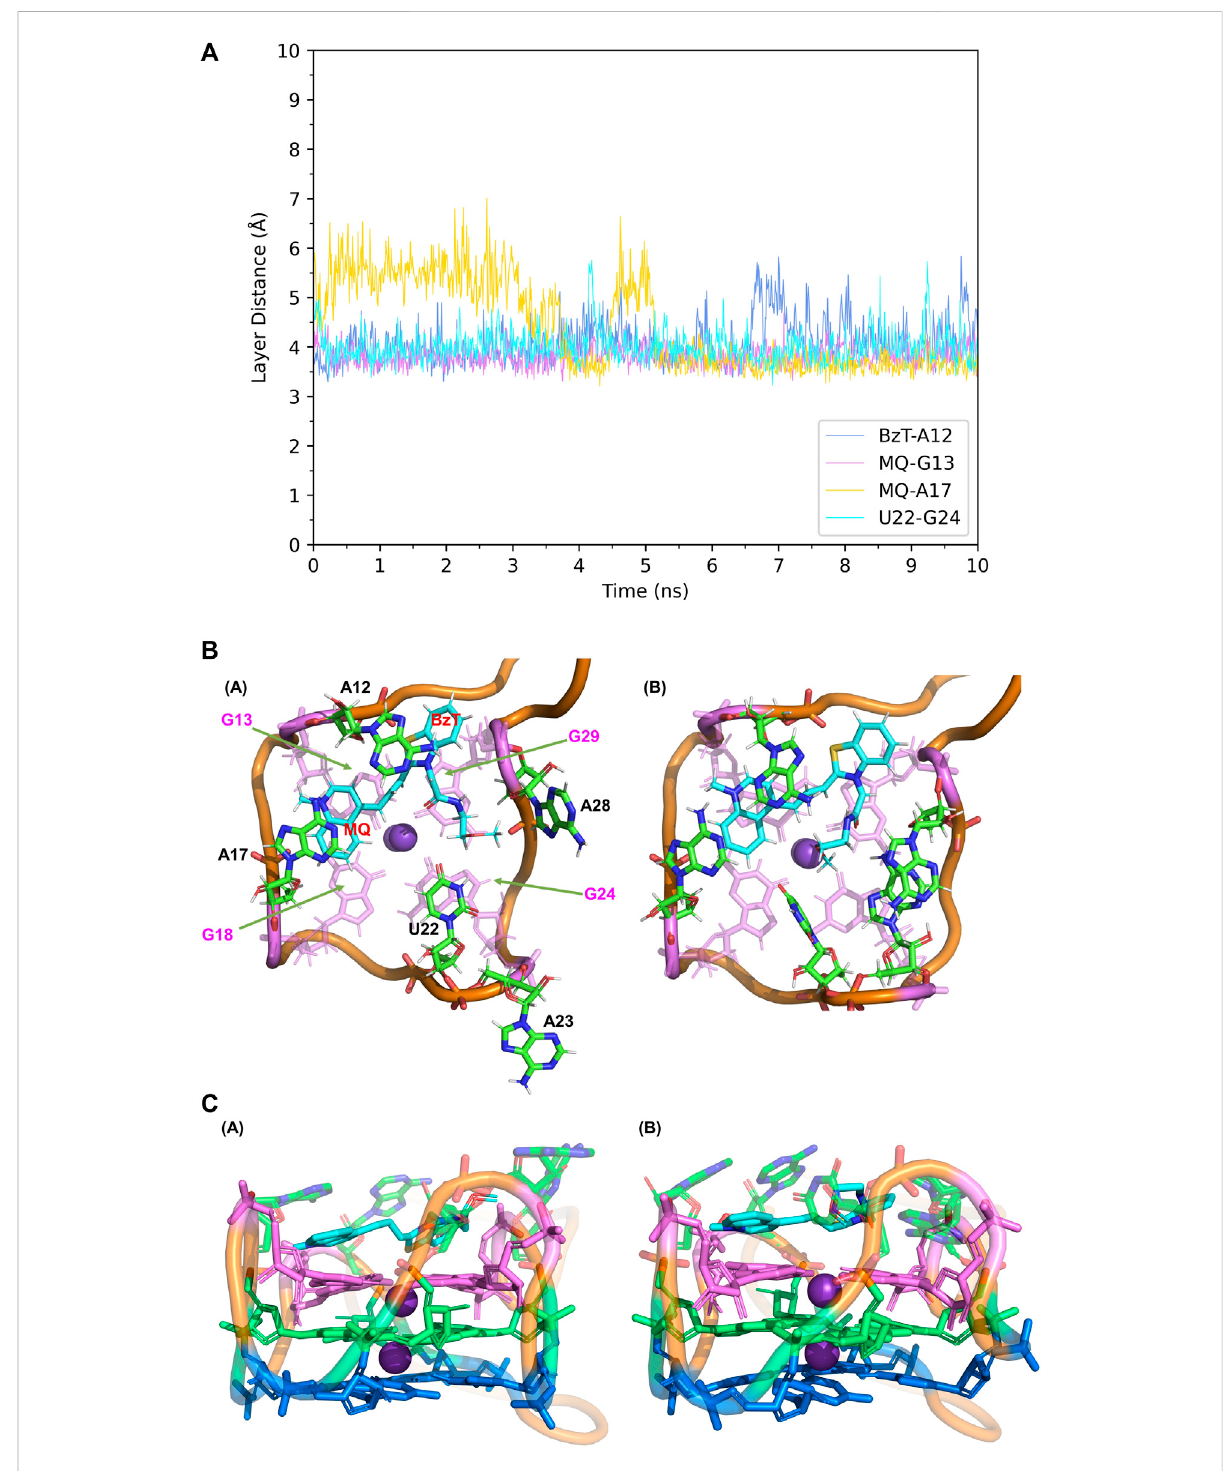
FIGURE 8 Structural analysis of MD simulation on Mango-II mutant (A22U) with TO3-Biotin. (A) : the trajectories of important structural parameters in the MDprocess. (B) :topviewsoftheequilibriumstructurefromtheMDprocess(bothat4nssnapshot)(Left:con fi gurationA;Right:con fi gurationB. (C) : side views of the equilibrium